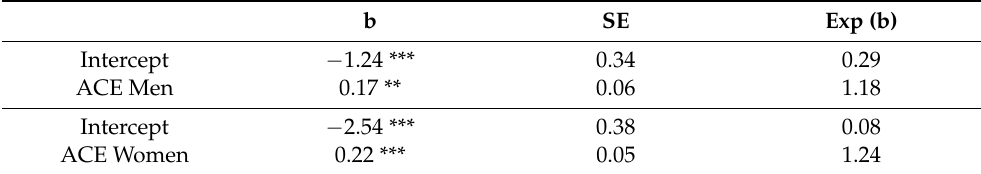
Table 13. Poisson model for criminal behaviors by sex. b SE Exp (b) Intercept